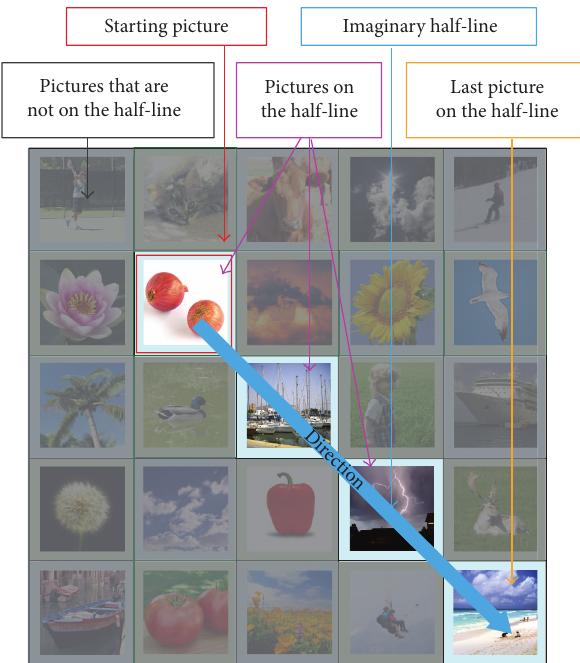
Figure 6: Determining whether a cued picture is on the half-line.